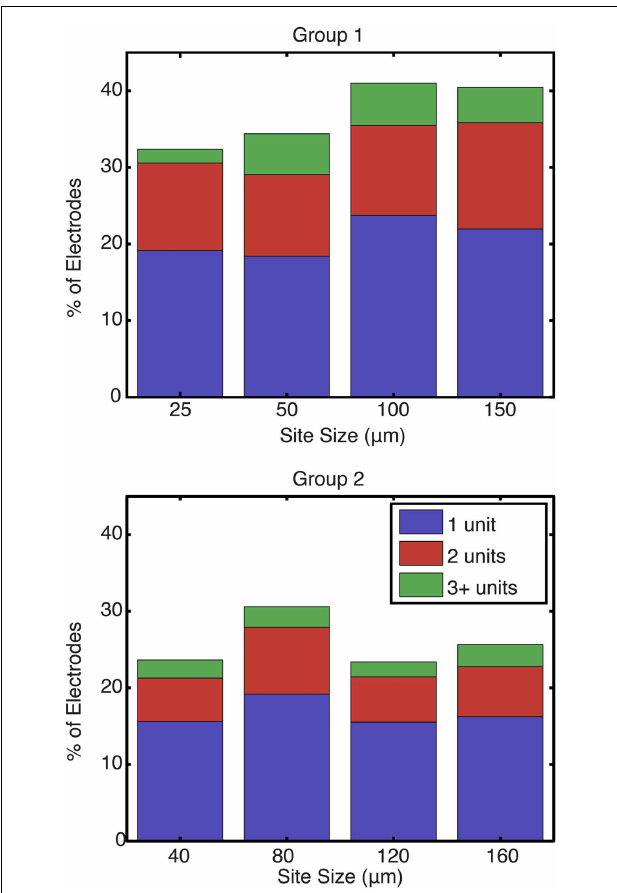
FIGURE 5 | Percentage of electrodes recording at least one unit by site size . For each site size, each bar represents the total percentage of electrodes that recorded at least one unit, while the stacks represent the percentage of functional electrodes that were able to record one, two, or more than three units in blue, red, and green, respectively. Site size was not found to be a significant factor on the number of units recorded per electrode ( p =